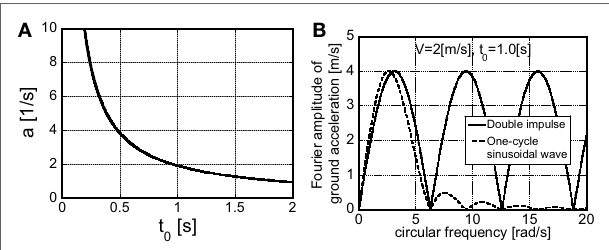
FIGURE A1 | Relation of amplitudes between double impulse and one-cycle sine wave, (A) coefficient a , (B) Fourier amplitude of double impulse and one-cycle sine